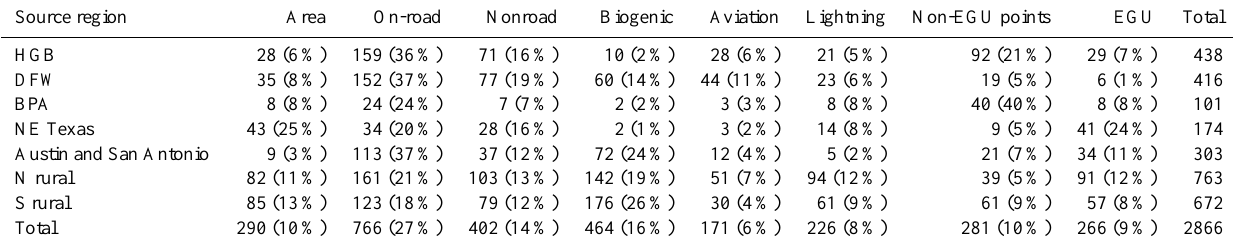
Table 1. NO x emission rates for seven sectors in seven inversion regions (tonsday − 1 ). Note: percentage indicates the apportionment of each emission sector to the regional